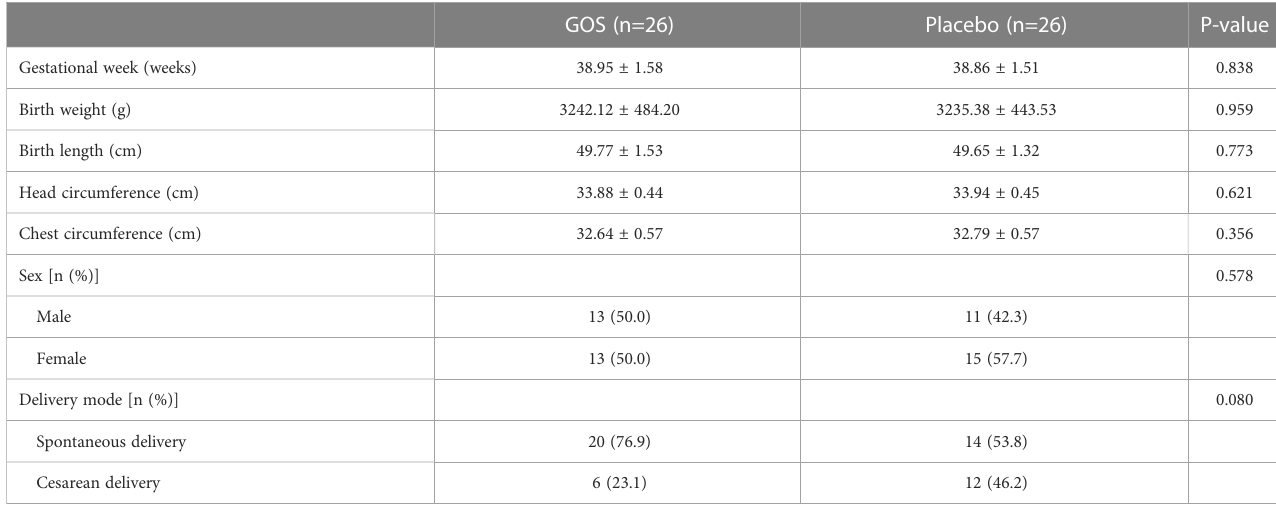
TABLE 4 Clinical characteristics of